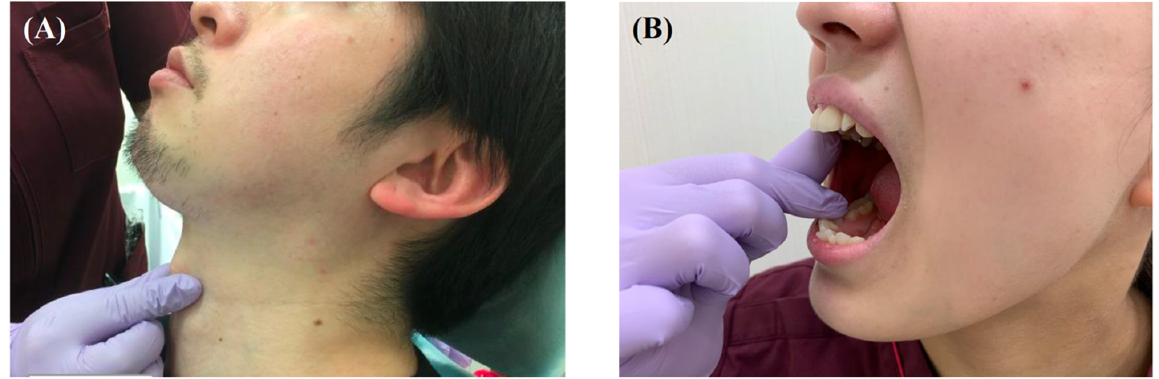
Figure 6. Functional swallowing exercises for oral cancer patients. ( A ) Performing the Mendelssohn maneuver. ( B ) Manual opening training.